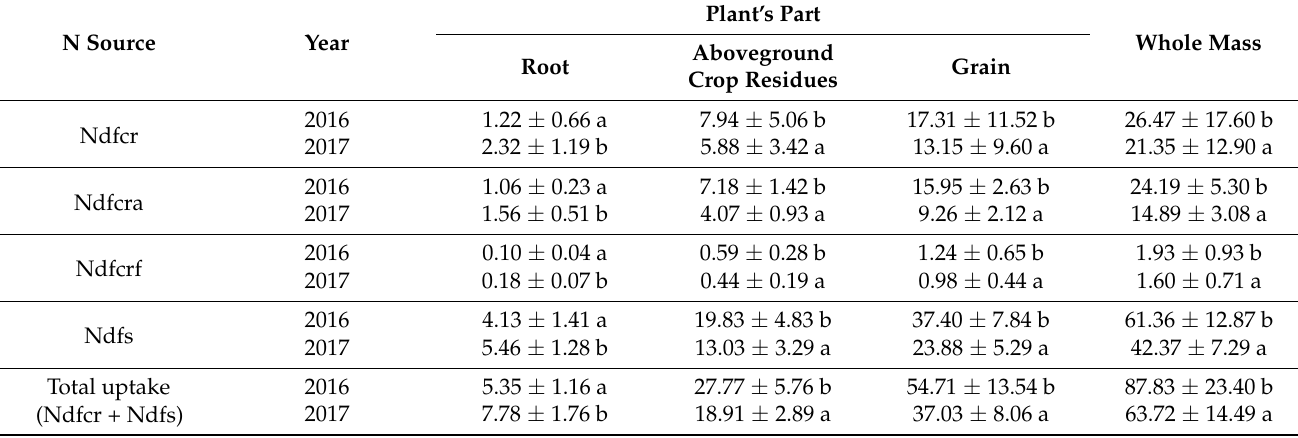
Table 7. Nitrogen uptake by winter triticale from different sources depending on the year of research, kg N · ha − 1 (averages ± SD).